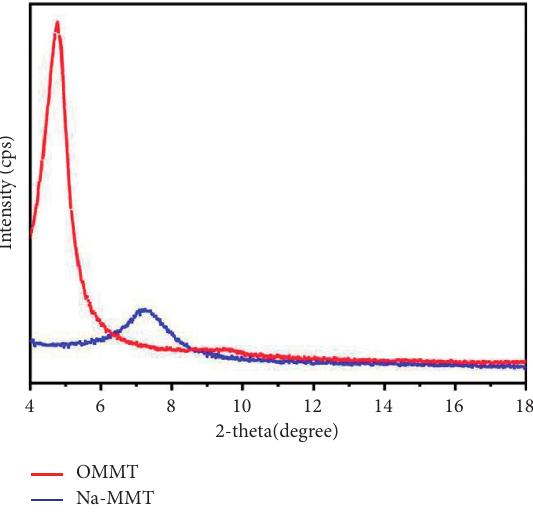
Figure 4: XRD patterns of Na-MMT and